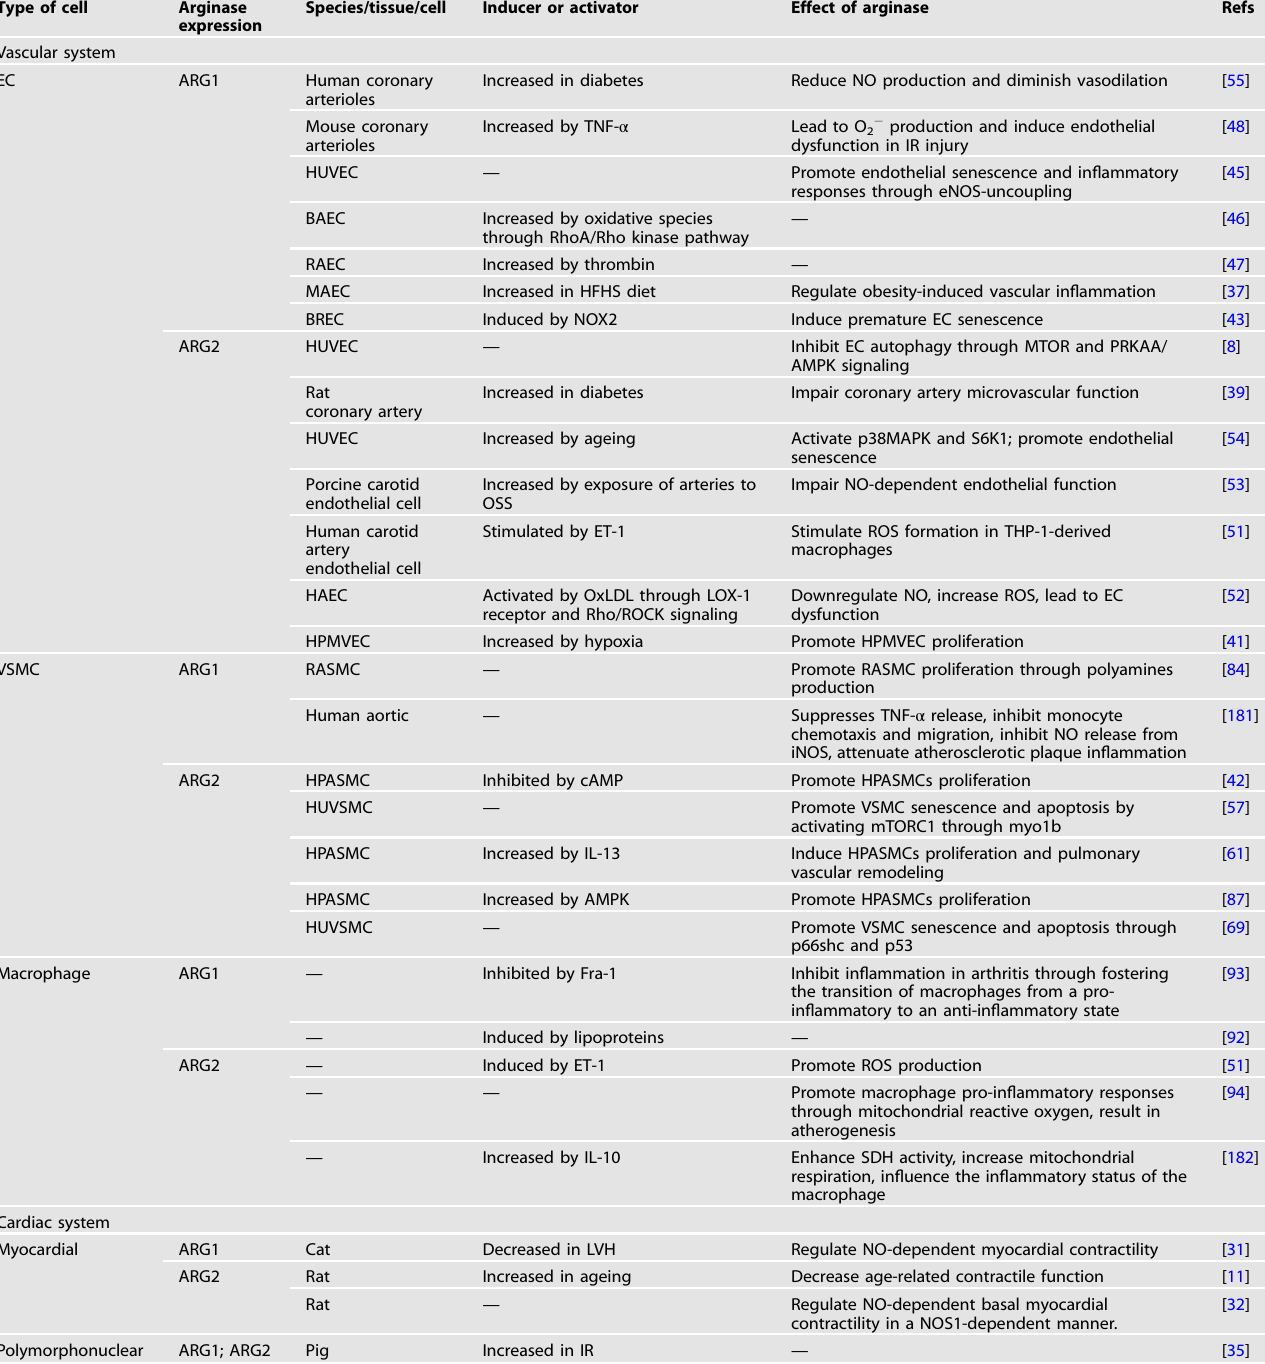
Table 1. Expression and function of arginase in cardiovascular